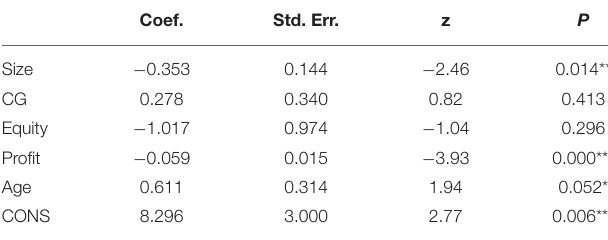
TABLE 11 | The Tobit regression results of factors influencing CSR efficiency.